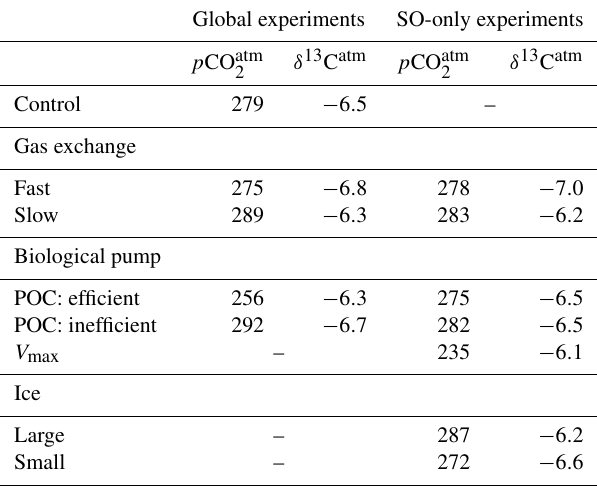
Figure 3. δ 13 C of DIC (‰) difference after 2000 years for the fast gas exchange experiments (experiment − control): global experiments (a, c) and SO-only experiments (b, d) , at 25m depth (a, b) and as a Pacific transect of δ 13 C difference (c, d) .